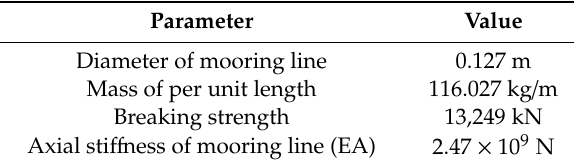
Table 2. Main parameters of the mooring line.